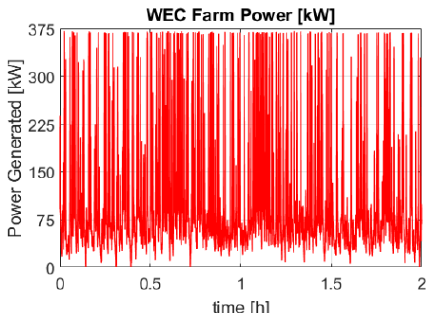
Figure 6. Power generation profile of the WEC plant.